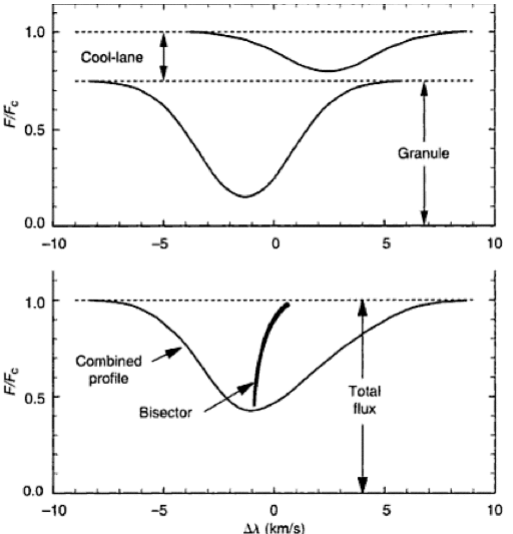
Figure 1. Schematic from [27] displaying the relative (top) and combined (bottom) contribution of the bright, blueshifted granules and the dark, redshifted intergranular lanes; note the lane profile has been artificially offset in flux for display purposes. The curvature in the line bisector displays the asymmetries in the combined profile.